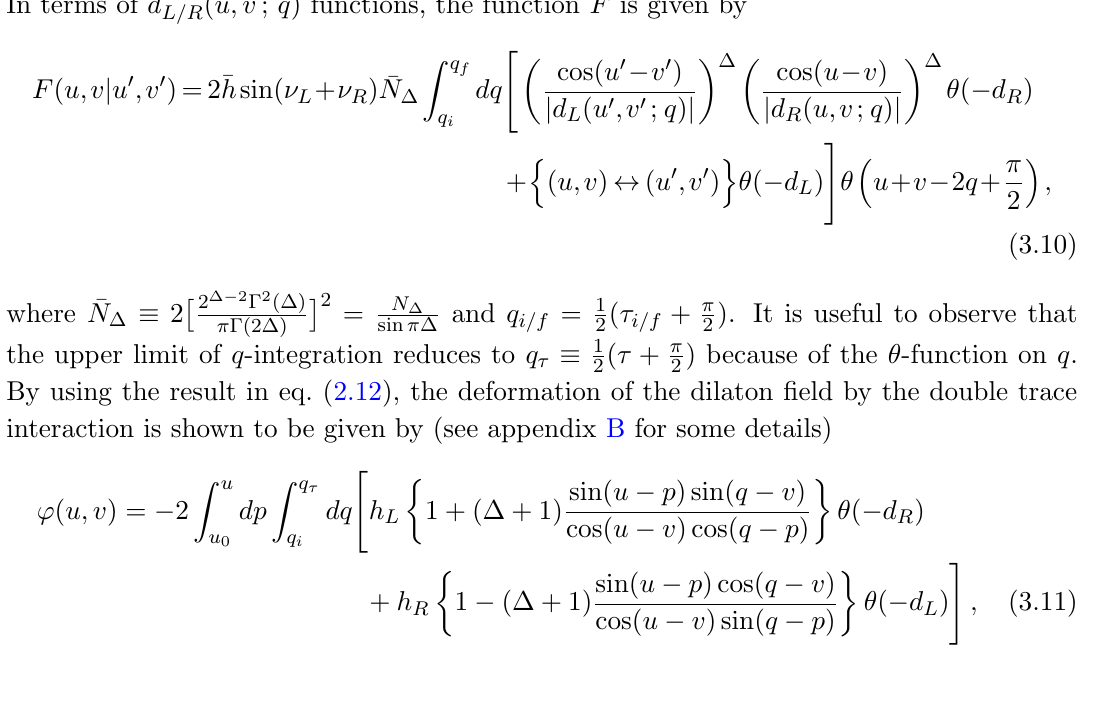
Figure 1 . The evaluation point for ’ and its related ones written in ( u; v ) coordinates in the global AdS, which are de(cid:12)ned by (cid:28) = u + v , (cid:22) = u (cid:0) v . time-like separated from the left/right boundary sources if and only if d